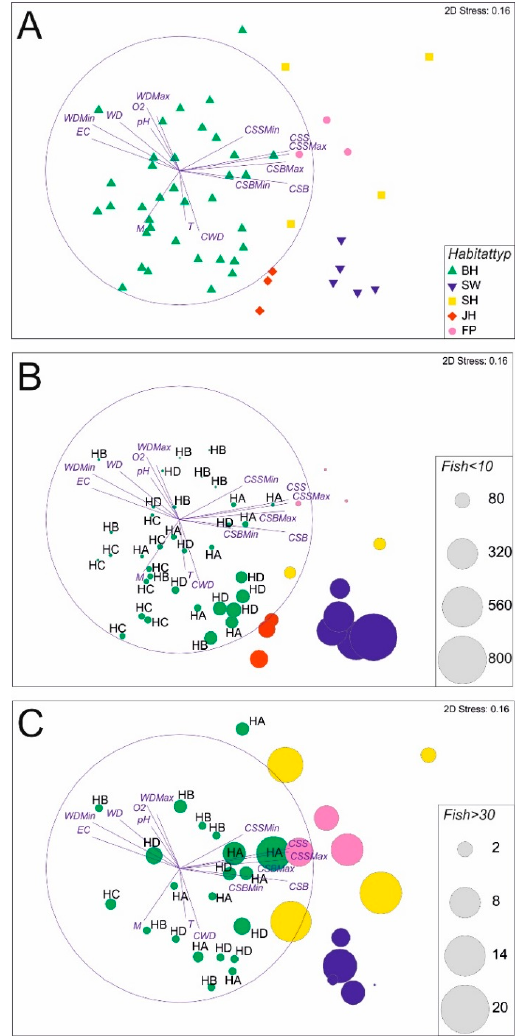
Figure 4. Fish community composition ( A ) in the five different habitat types plotted as a non-metric multidimensional scaling (NMDS). JH = structured shallow water zones displayed in red rhombi, BH = bank habitats (HA, HB, HC, and HD) in green triangles, SW = former river course below the spillway in dark blue triangles, SH = fast flowing instream habitat with gravel in yellow squares, FP = nature like fish pass in pink dots. JH, BH, SW, SH, and FP, refer also to the five habitat types, as described above (Figure 3). Circles in part B and C of Figure 4 are proportional in size to the number of caught fish (N) per individual replicate of the habitat. Individuals <10 cm = fish individuals smaller than 10 cm total length (part B ) and Individuals >30 cm = fish individuals larger than 30 cm total length (part C ). WD = water depth, CSS = current speed measured 5 cm below water surface (ms − 1 ), CSB = current speed measured 5 cm above river bottom (ms − 1 ), O 2 = concentration of dissolved oxygen (mgl − 1 ), T = temperature (°C), EC = electric conductance (µScm − 1 ), pH = pH-value, M = estimated macrophyte coverage (%), CWD = estimated coverage of coarse woody debris (%), CG = coarse gravel introduced, Min = minimum values, Max = maximum values. All the measured Physico-chemical variables were correlated on the NMDs plot and printed as blue lines. Length of the lines is proportional to the degree of correlation with the arrangement of fish community data (the blue circle indicates 100% correlation).